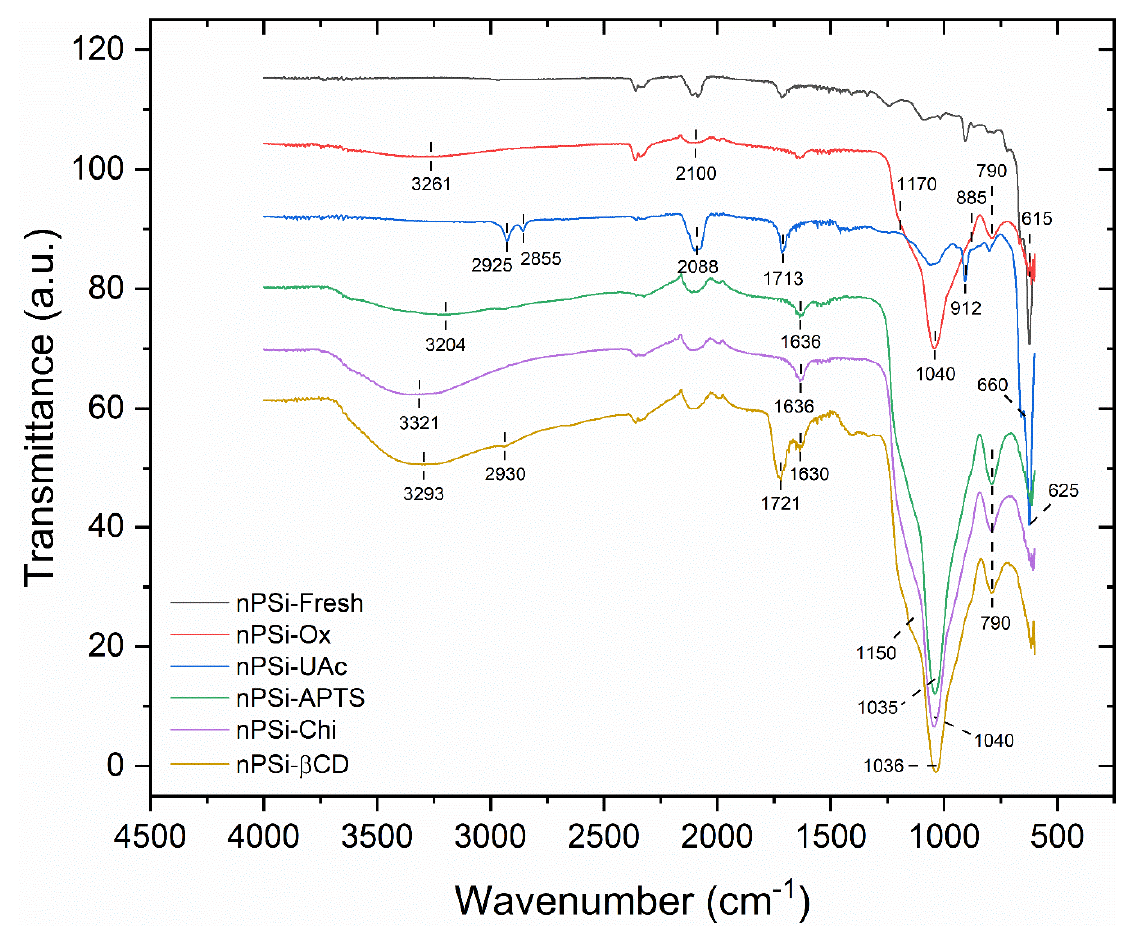
Figure 4. FT-IR spectra of the different functionalities of porous silicon nanostructures.